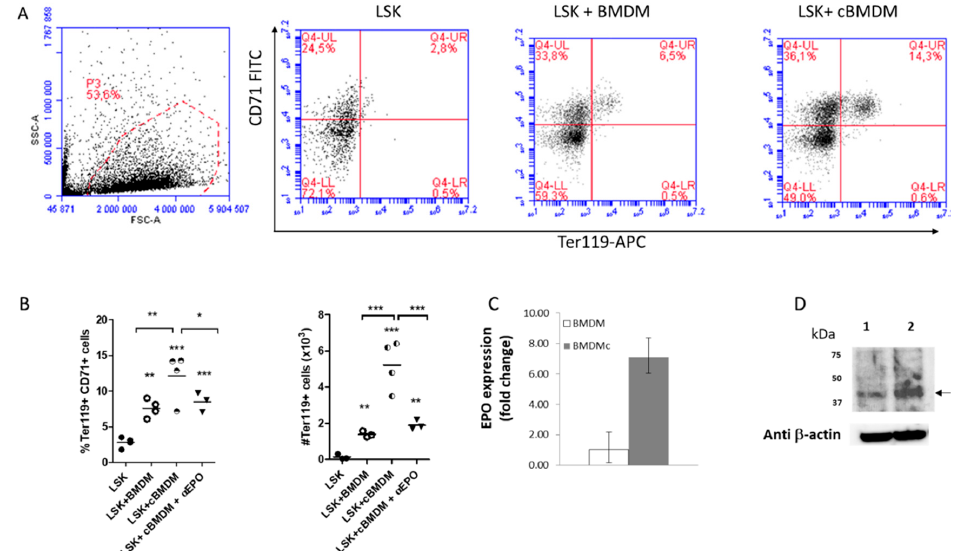
Figure 1. Bone marrow-derived macrophages produce erythropoietin (EPO) and stimulate erythroid cells di ff erentiation in vitro. ( A ) Lineage - cKit + Sca1 + (LSK) cells were cultured for 5 days in an erythropoietic media without exogenous EPO, alone or in the presence of BMDM or BMDM